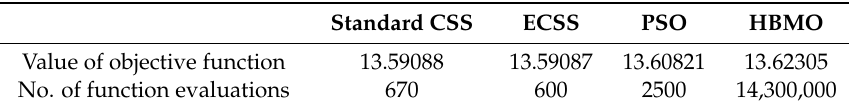
Table 3. Results of the CSS and ECSS algorithms in comparison with the other heuristics for the constrained exponential